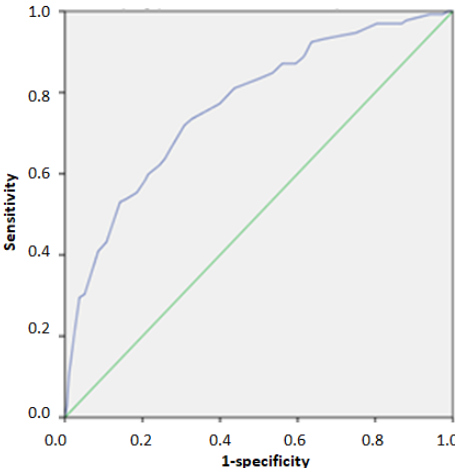
Nutrients 2020 , 12 , x FOR PEER REVIEW Figure 1. ROC Curve for identifying individuals above the 75th percentile of HOMA-IR. Figure 1. ROC Curve for identifying individuals above the 75 th percentile of HOMA-IR.